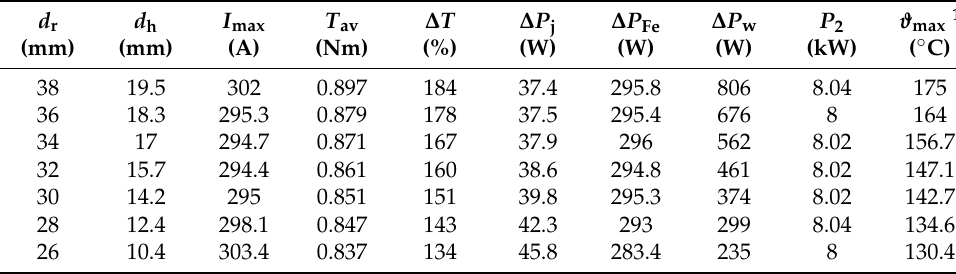
Table 4. Results of the rotor-diameter analysis.